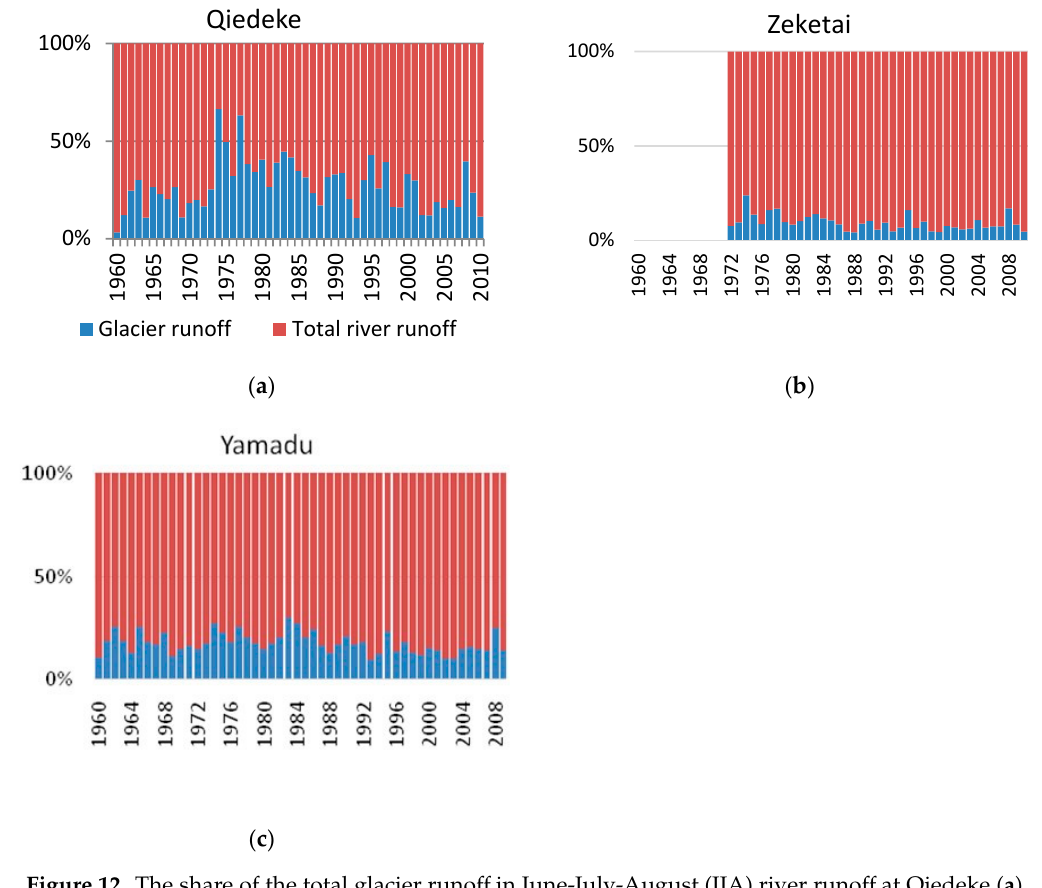
Figure 12. The share of the total glacier runo ff in June-July-August (JJA) river runo ff at Qiedeke ( a ), Zeketai ( b ) and Yamadu ( c ) stations.